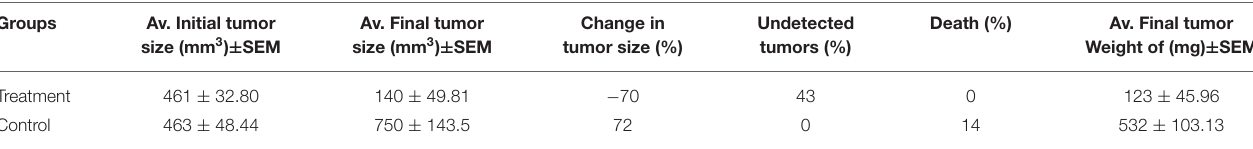
TABLE 4 | Effect of Gaz alafi ethanol extract treatment on tumor size, weight, tumors detection, and deaths percentages, in the EMT-6/P cell line, where (mm 3 ) is a cubic millimeter ( n = 7).